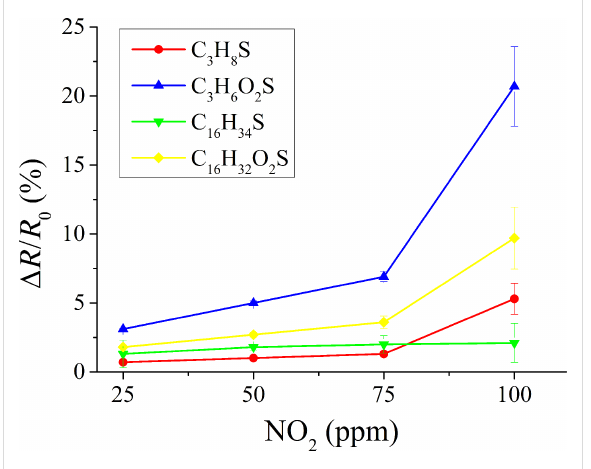
Figure 7: Calibration curves for different concentrations of nitrogen dioxide under humid conditions (50%